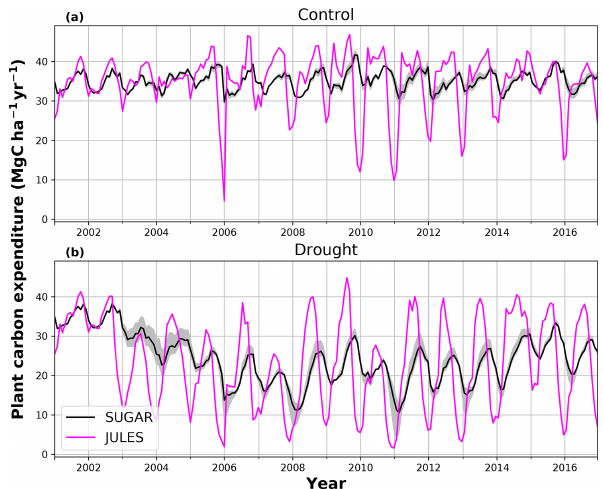
Figure A3. Simulated plant carbon expenditure (PCE) from JULES and SUGAR for (a) the control and (b) the throughfall exclusion (TFE) plots at Caxiuanã. A sensitivity study on the parameter a K in SUGAR was carried out, and the maximum, minimum and ensemble mean m PCE are presented. Time series observations of PCE from the site were not available.